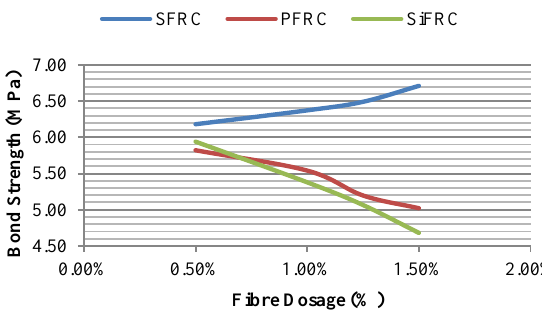
Figure 3. Performance of mono-FRC at 28 days